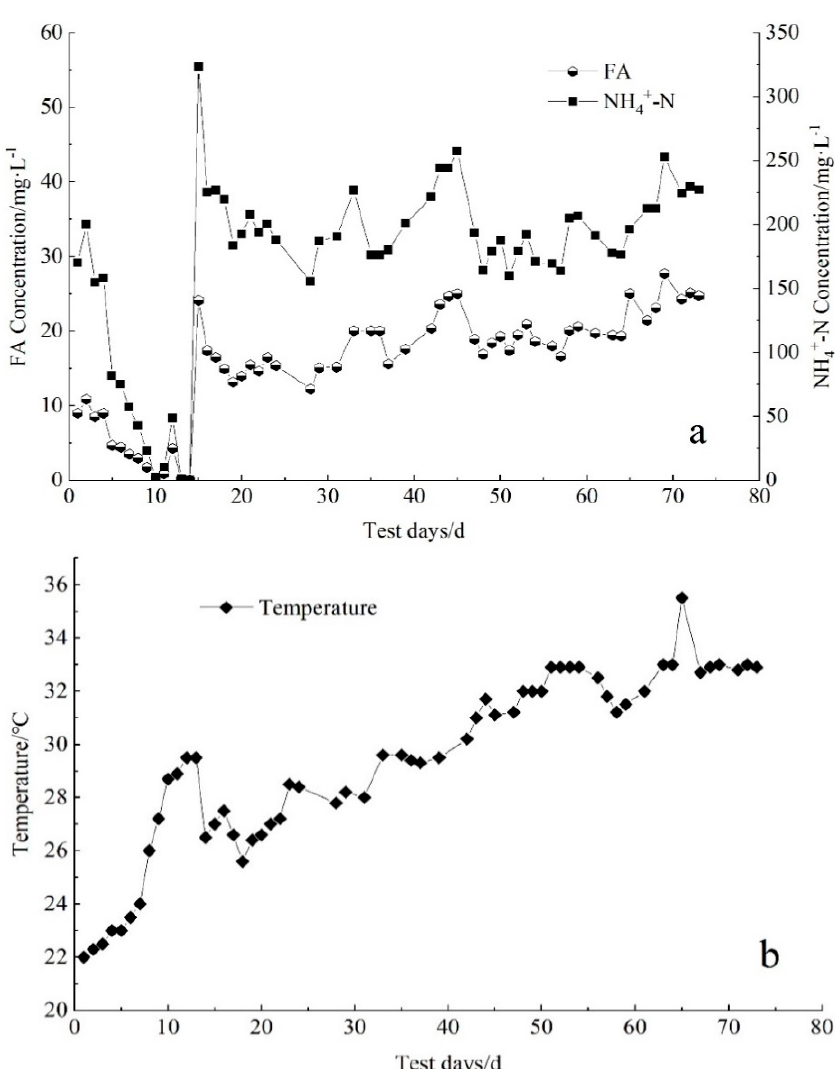
Figure 3. Changes in the content of polysaccharides and protein in ( a ) EPS and ( b ) SMP under different FA. EPSs, SMP S are polysaccharides and EPS P , SMP P are proteins, respectively.